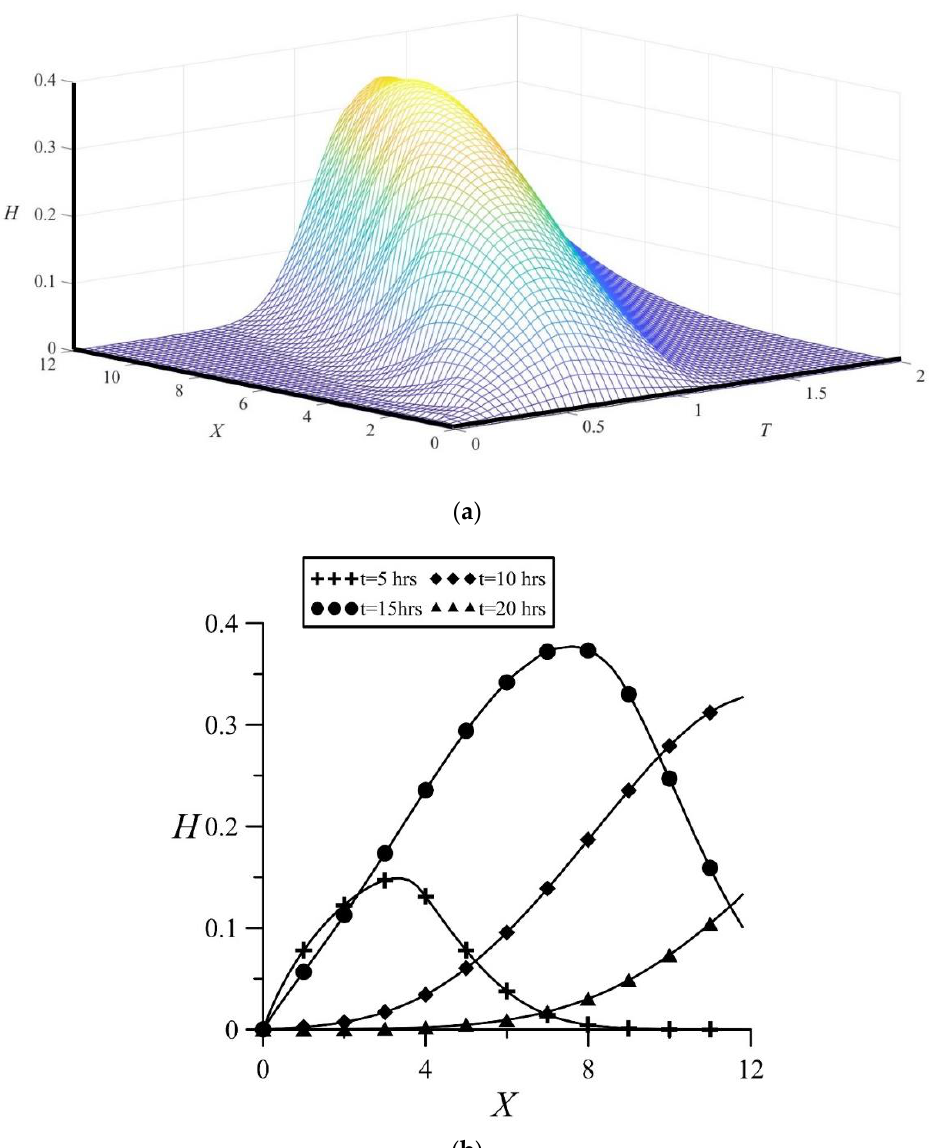
Figure 7. The effect of a unimodal rainfall event with hourly data Figure 7. The e ff ect of a unimodal rainfall event with hourly data (10, 20, 30, 40, 50, 60, 50, 40, 30, 20, 10 ( 10, 20, 30, 40, 50,60,50, 40, 30, 20, 10 mm/hr) on the groundwater level with parameters 𝛼 = mm / hr) on the groundwater level with parameters α = 39.2157, U = 20.7444. ( a ) spatiotemporally 39.2157 , 𝑈 = 20.7444 . ( a ) spatiotemporally distributed variation of groundwater level, and ( b ) distributed variation of groundwater level, and ( b ) variation of groundwater level in space at some variation of groundwater level in space at some specific moments. specific